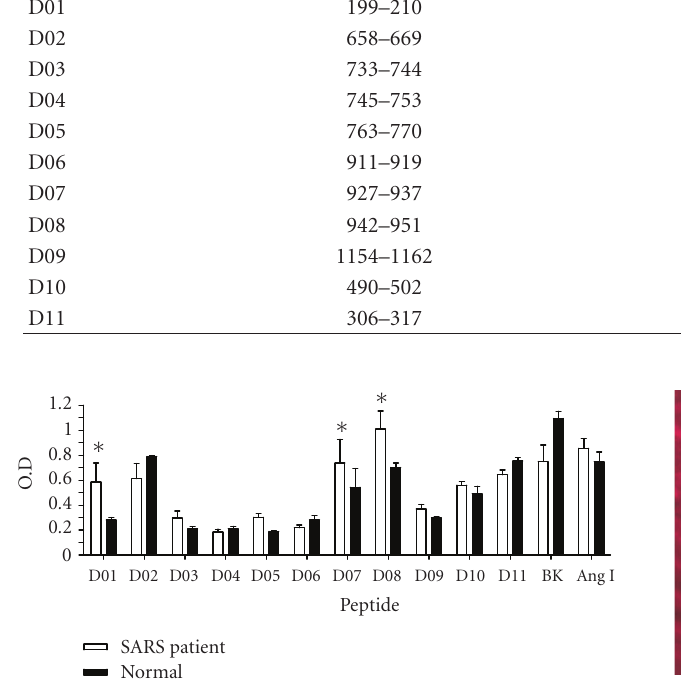
Figure 3: Antibody binding activity of SARS patients’ sera to di ff er- ent peptides. Sera of SARS patients at convalescent stage as well as normal controls were collected as described in Section 2. Antibodies binding to di ff erent peptides were detected by ELISA as described in Section 2. BK represents bradykinin. “ ∗ ” indicates P < .05.